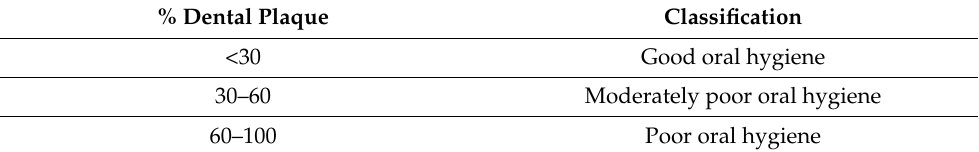
Table 2. Modified Approximal Plaque Index (MAPI) index interpretation